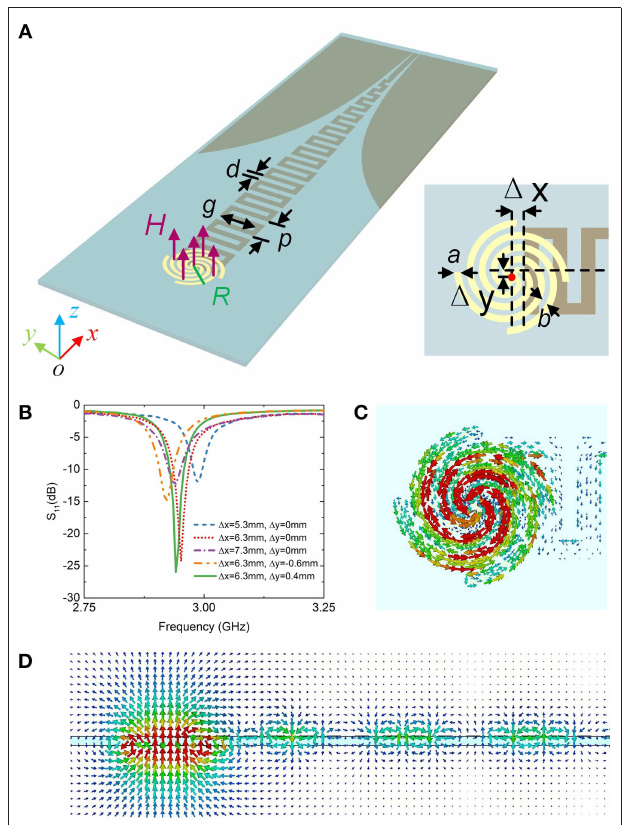
FIGURE 4 | (A) Plasmonic metamaterial antenna fed with the proposed SSPPs waveguide configuration. (B) S-parameter results for various MSS disk locations. (C) The simulated current distributions of the spoof plasmonic resonance mode and the feeding end. (D) Magnetic field vector distributions at cutting plane y = 0.